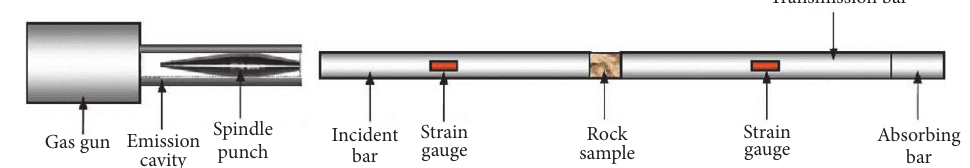
Figure 2: The functional diagram of SHPB.